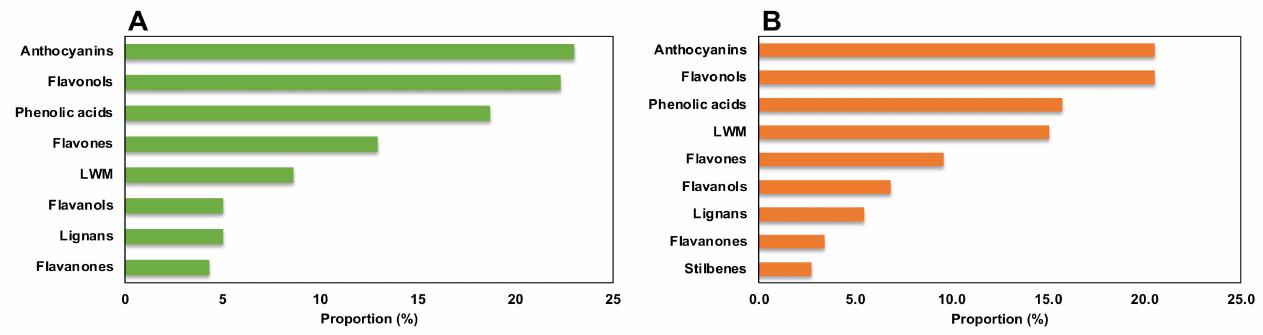
Figure 3. Proportion of compounds predicted as discriminant for the phenolic profile among ( A ) Bryophyllum species and ( B ) plant